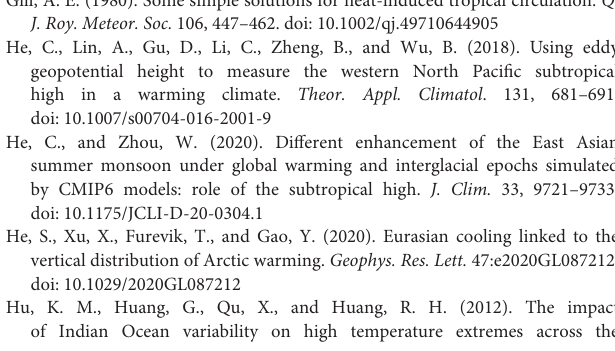
et al., 2018; He and Zhou, 2020; Jia et al., 2021). For example,